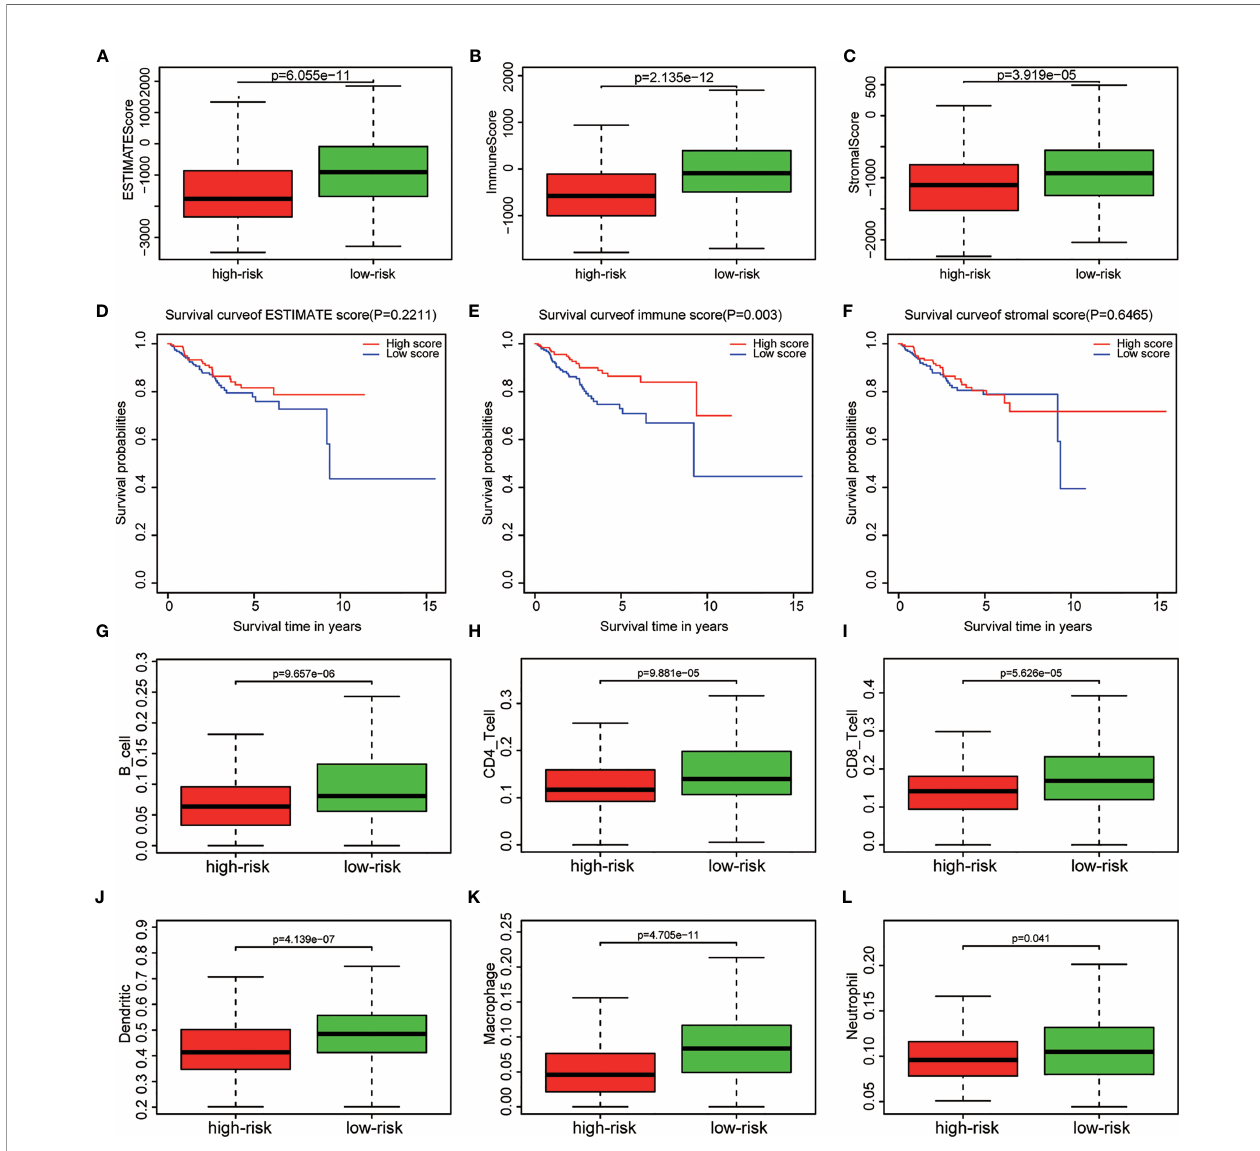
FIGURE 6 | Relationship between immune, stromal, total scores and the metabolism-related risk signature in TCGA cohort. Distribution of (A) immune scores, (B) stromal scores, and (C) ESTIMATE scores in the different risk groups. Survival curves in different (D) immune score, (E) stromal score, and (F) ESTIMATE score groups. Differential distributions of immune cells in the two risk groups. Wilcoxon rank-sum test accurately compared the difference and indicated that six immune cells conferred signi fi cantly lower in fi ltrating density in the high-risk groups, including (G) B cells, (H) CD4+ cells, (I) CD8+ cells, (J) Dendritic cells, (K) Macrophages, (L)